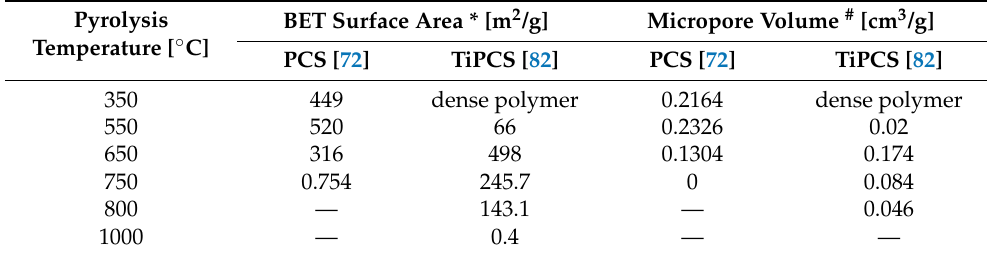
Table 5. BET surface area and micropore volume based on nitrogen adsorption for the PCS powders and TiPCS powders as a function of pyrolysis temperature (all powders were air cured at 200 ◦ C for 2 h and pyrolyzed under the same conditions).